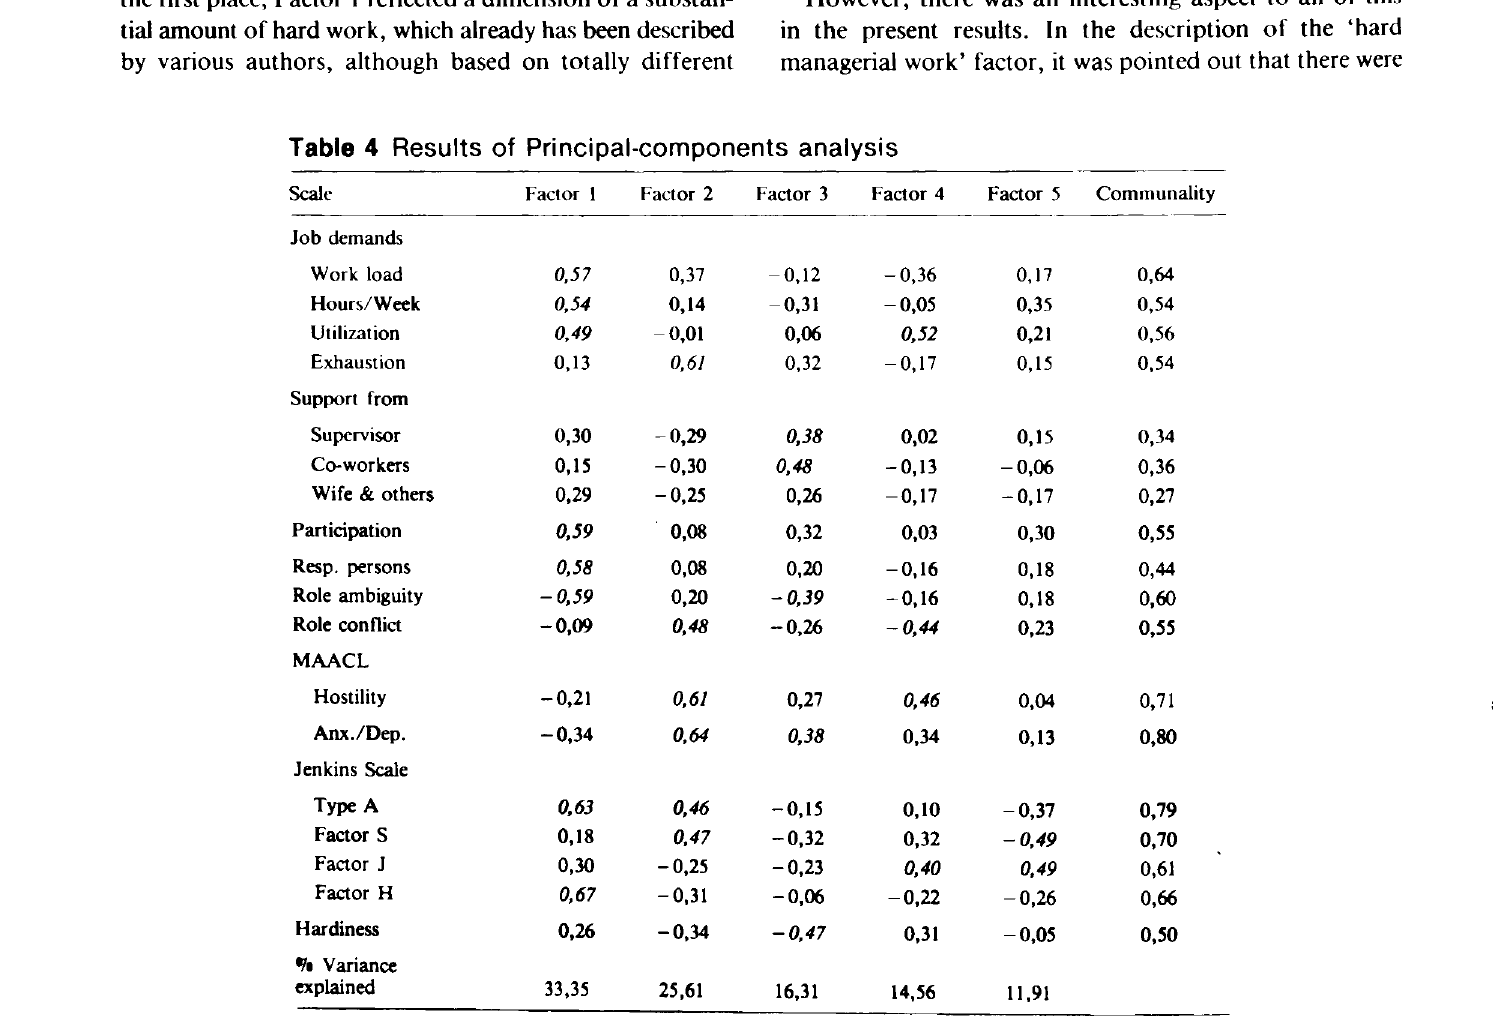
Table 4 Results of Principal-components